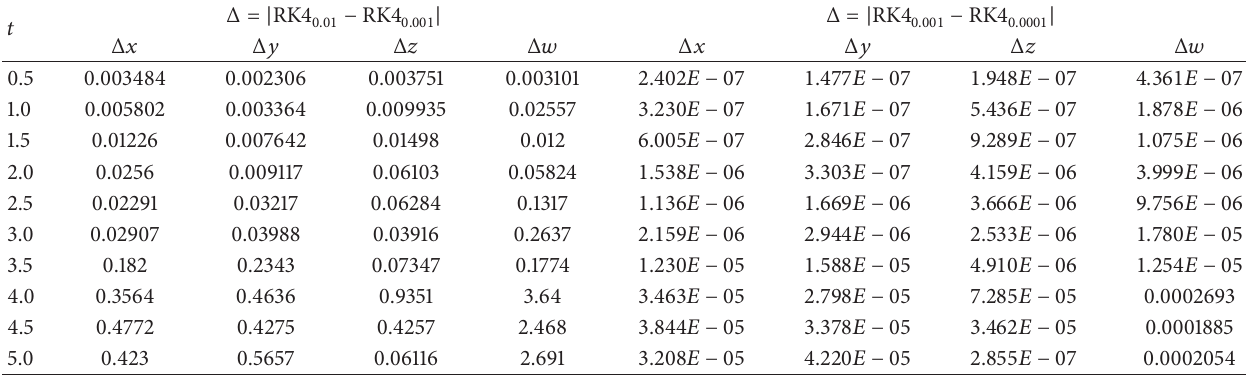
Table 3: Determination of accuracy of RK4 for hyperchaotic L¨u system for Case 2 .